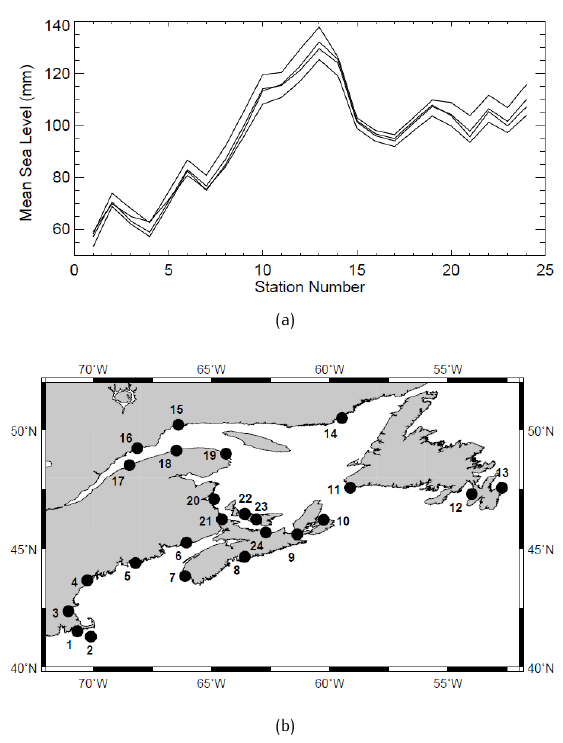
Figure 10. (a) Variation in MSL for the stations on the Atlantic coast oftheUSAandCanadashownin(b)usingthetide+surge model of Bernier and Thompson (2006). The four lines correspond to the decades 1960-69, 1970-79, 1980-89 and